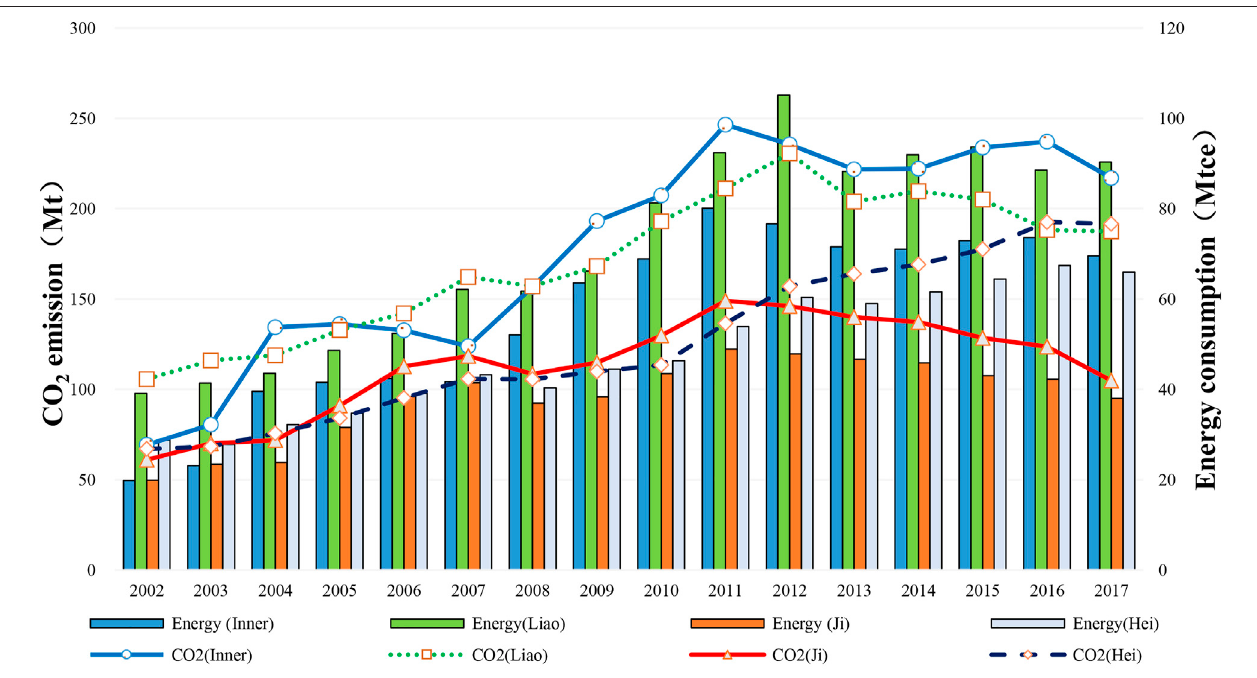
FIGURE 1 | Evolution of energy consumption and CO 2 emissions in the four northeastern